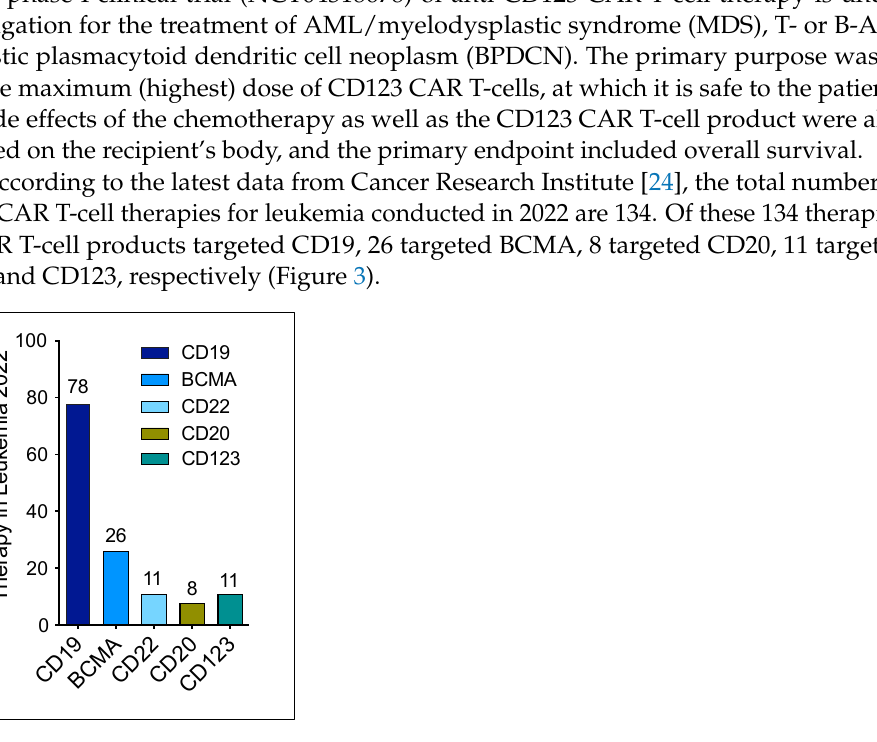
Figure 3. Active CAR T-cell therapies in leukemia in 2022. A total of 134 CAR T-cell trials were conducted in 2022 based on different targets.